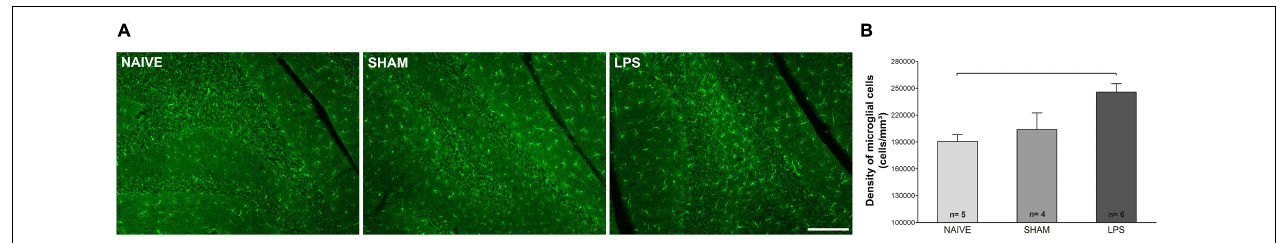
FIGURE 3 | Photomicrographs and microglial densities in the cerebellum of adult rats (PN89) after early neonatal LPS-induced inflammation. (A) Representative immunofluorescence of microglial cells in the three animal groups. Calibration bar: 200 µ m. (B) The density of Iba1 + cells increased in the LPS group. Values: mean ± SEM. ANOVA, Tukey post hoc test, bar: p < 0.01 vs naïve.